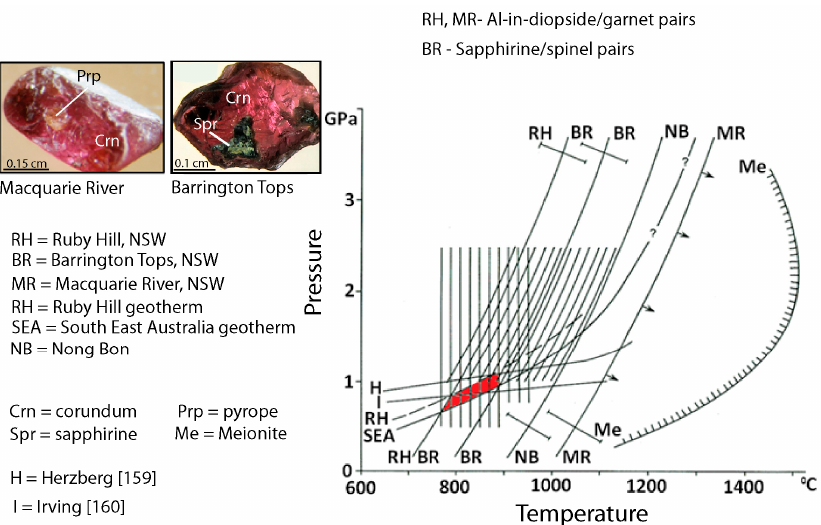
Figure 24. Thermometric traces for mineral inclusion pairs for rubies from Australia (Ruby Hill, Barrington Tops, and Macquarie River) and Thailand (Nong Bon), modified from [81]. The P (GPa)–T ( ◦ C) diagram is based on Al- in diopside / garnet and sapphirine / spinel pairs, after [75,136]. The traces intersect the T range for Barrington Tops rubies (vertical lines), the East Australian ruby-bearing xenolith-derived Mesozoic garnet granulite (RH) and late Cenozoic (SEA) geotherms, the garnet to spinel pyroxenite transition of [159] (H), and the garnet-clinopyroxene-plagioclase transition of [160] (I). The red area represents P 6–8 kbar for the Barrington Tops ruby suite. The extreme Al-rich diopside and meionite-bearing Macquarie River ruby suggests a P–T crystallization between thermometric trace (MR) and the meionite stability boundary